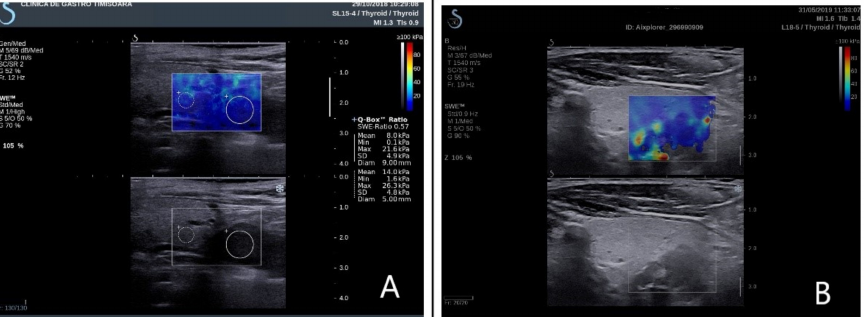
Figure 1. Elastograms overlapping on the B-mode image. ( A ) Right inferior parathyroid adenoma in primary hyperparathyroidism; ( B ) right inferior parathyroid hyperplasia in secondary hyperparathy- roidism.